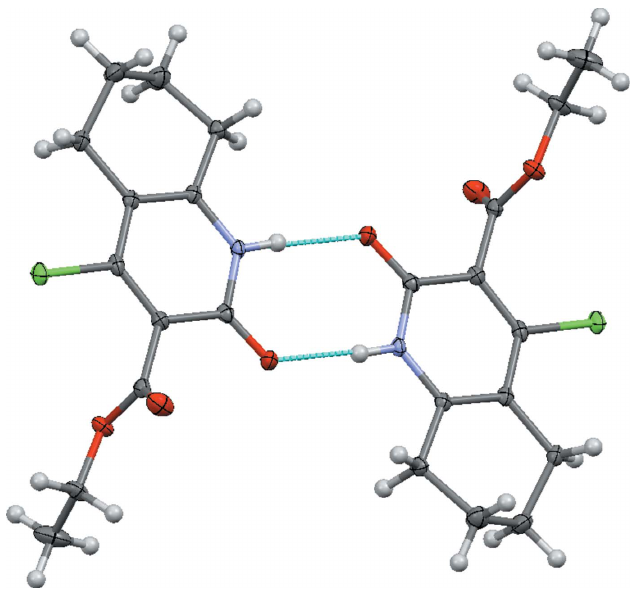
Figure 2 Dimers formed by classical N—H (cid:3)(cid:3)(cid:3) O hydrogen-bonding interactions, dashed lines.